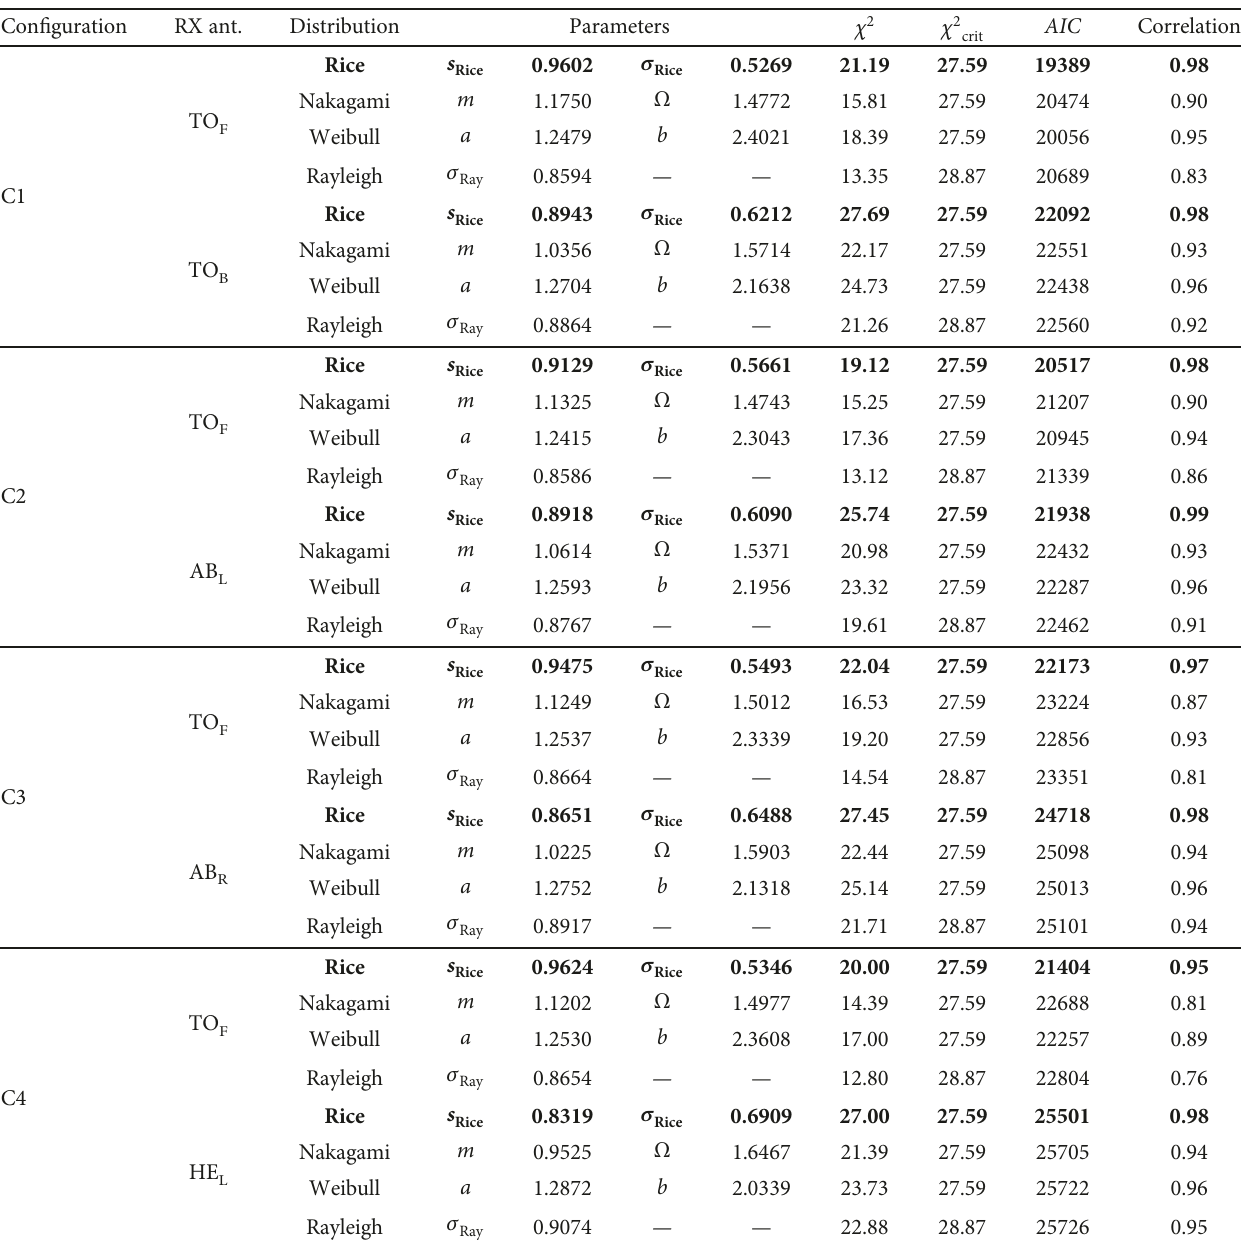
(a) Results of the fast fading distribution fi tting for con fi gurations C1 – C4 Con fi guration RX ant.